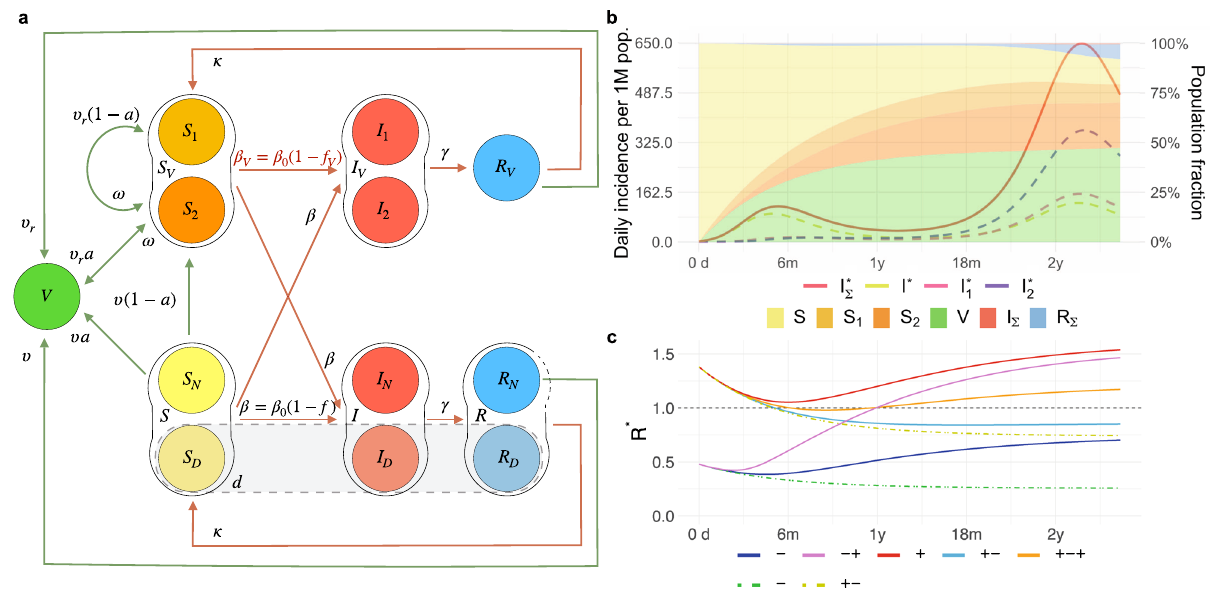
Fig. 1 The VAP-SIRS model and its predicted scenarios. a Graphical scheme of the VAP-SIRS model. b, c Predicted scenarios for the reference setup for the Delta variant, with vaccine effectiveness a = 0.79 (corresponding to the effectiveness of the Comirnaty vaccine against infection with the Delta variant), slow (re-)vaccination rate ( υ = υ r = 0.004; typical for many European countries), slow immunity waning ω = 0.002, low fraction of never- vaccinated ( d = 0.12; corresponding to the fraction in the United Kingdom) and proportional mixing (see Methods). b Color curves: Timeline of daily incidence per 1 million inhabitants in different infected compartments for the combination of restrictions f = 0.77 and f v = 0.55. A variable with the asterisk (*) indicates that we consider a daily incidence over the corresponding variable. The dashed lines describe infected who are: non-vaccinated ( I * , yellow), vaccinated who did not gained immunity ( I (cid:3) ), and vaccinated who already lost immunity ( I (cid:3) ). By I (cid:3) Σ (red, solid line) we mean the sum of all daily infected 1 2 þ I (cid:3) ( I (cid:3) D þ I (cid:3) N þ I (cid:3) ). Color bands: Muller plot of the population structure (the width of the color band in the y axis) as a function of time (x axis) for the same 1 2 parameter settings. Colors correspond to speci fi c subpopulations: non-vaccinated susceptible ( S , yellow), vaccinated susceptible who did not gained immunity ( S 1 , light orange) vaccinated susceptible who already lost immunity ( S 2 , dark orange), vaccinated immunized ( V , green). Moreover, by I Σ (red) and R Σ (blue) we denote all infected and all recovered (independently of vaccination result), respectively. c Time evolution of the instantaneous reproduction number R (cid:3) (y axis) depending on the number of days counted from the start of the vaccination program (x axis), in fi ve different scenarios describing the epidemic evolution: overcritical ( + , red, f = 0.77 and f v = 0.38), subcritical ( - , blue, f = 0.92 and f v = 0.71), initially and eventually overcritical ( + - + , orange, the same restrictions as in b : f = 0.77 and f v = 0.55), eventually overcritical ( - + , pink, f = 0.92 and f v = 0.38), and eventually subcritical ( + - , cyan, with f = 0.77 and f v = 0.71). As controls, two additional scenarios of the epidemic evolution are presented, corresponding to no implementation of VPs and no changes in behavior due to vaccination: subcritical (another example of - scenario, green) with f = f v = 0.92 and eventually subcritical (another example of + - scenario, yellow) with f = f v = 0.77, both plotted with dot-dashed